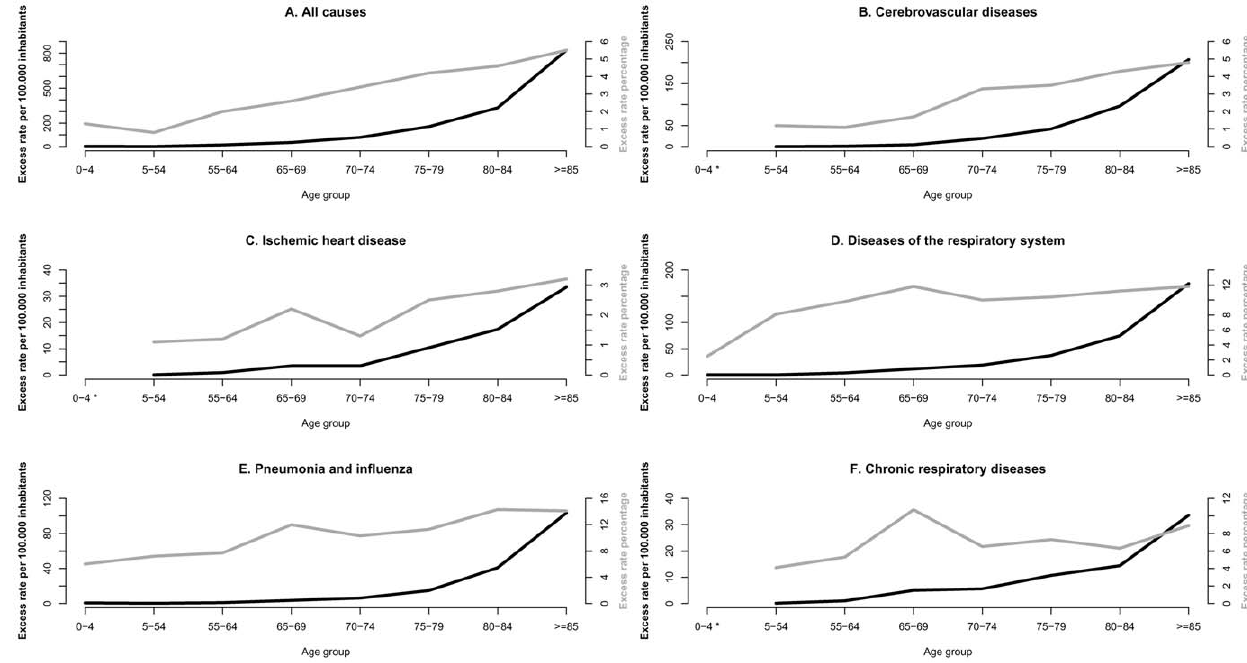
Figure 2. Age-specific influenza excess mortality burden. Average rates (per 100.000 persons) and proportion of winter mortality associated with influenza epidemics from 1980–1981 to 2003–2004 by age group: A. All causes, B. Cerebrovascular diseases, C. Ischemic heart diseases, D. All respiratory diseases, E. Pneumonia and Influenza (P&I), F. Chronic respiratory diseases. (* data not presented due to low annual number of deaths). The proportion of winter mortality attributable to influenza was calculated as the ratio of seasonal excess mortality to mortality occurring during Oct– Mar, for each disease outcome and age group.